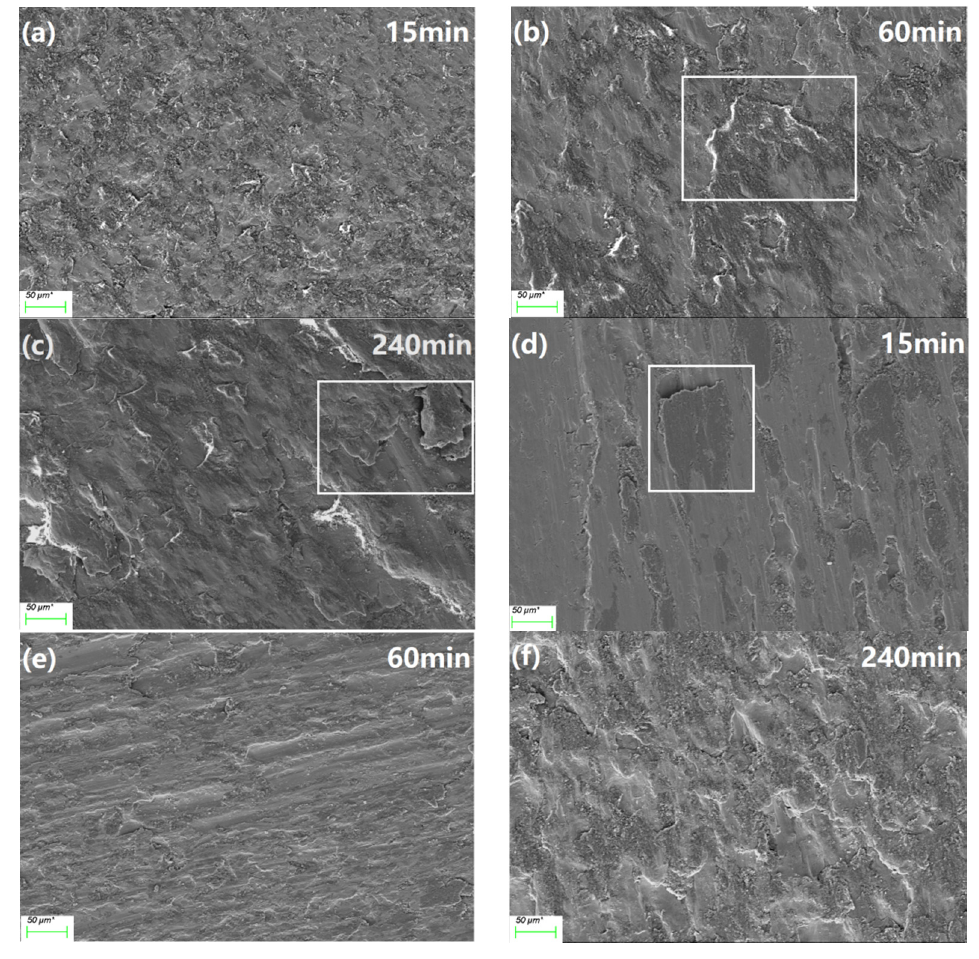
Figure 4. Surface morphology of pin sample in rotary ( a – c ) and reciprocating sliding ( d – f ) under different sliding durations.